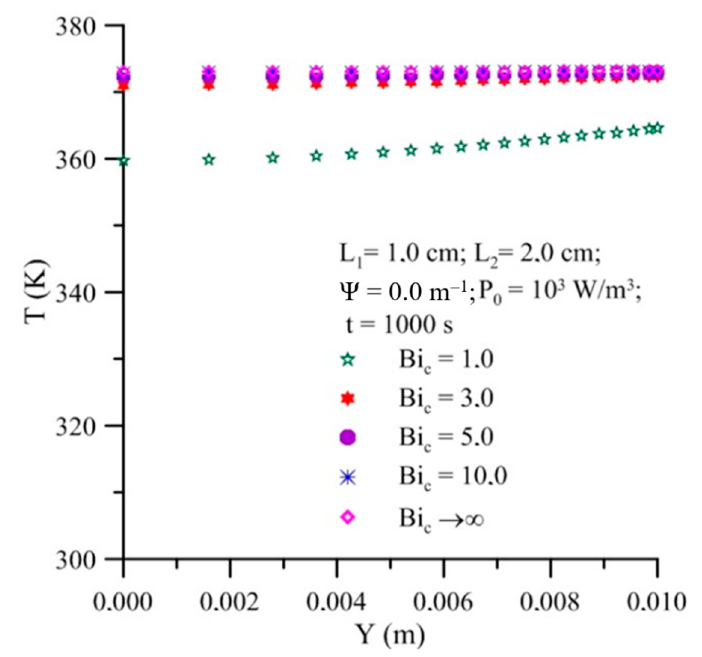
Figure 11. Temperature inside a prolate spheroidal solid with aspect ratio L 2 /L 1 = 2.0, different heat transfer Biot numbers and fixed microwave power density ( y -axis, z = 0, t = 1000 s).